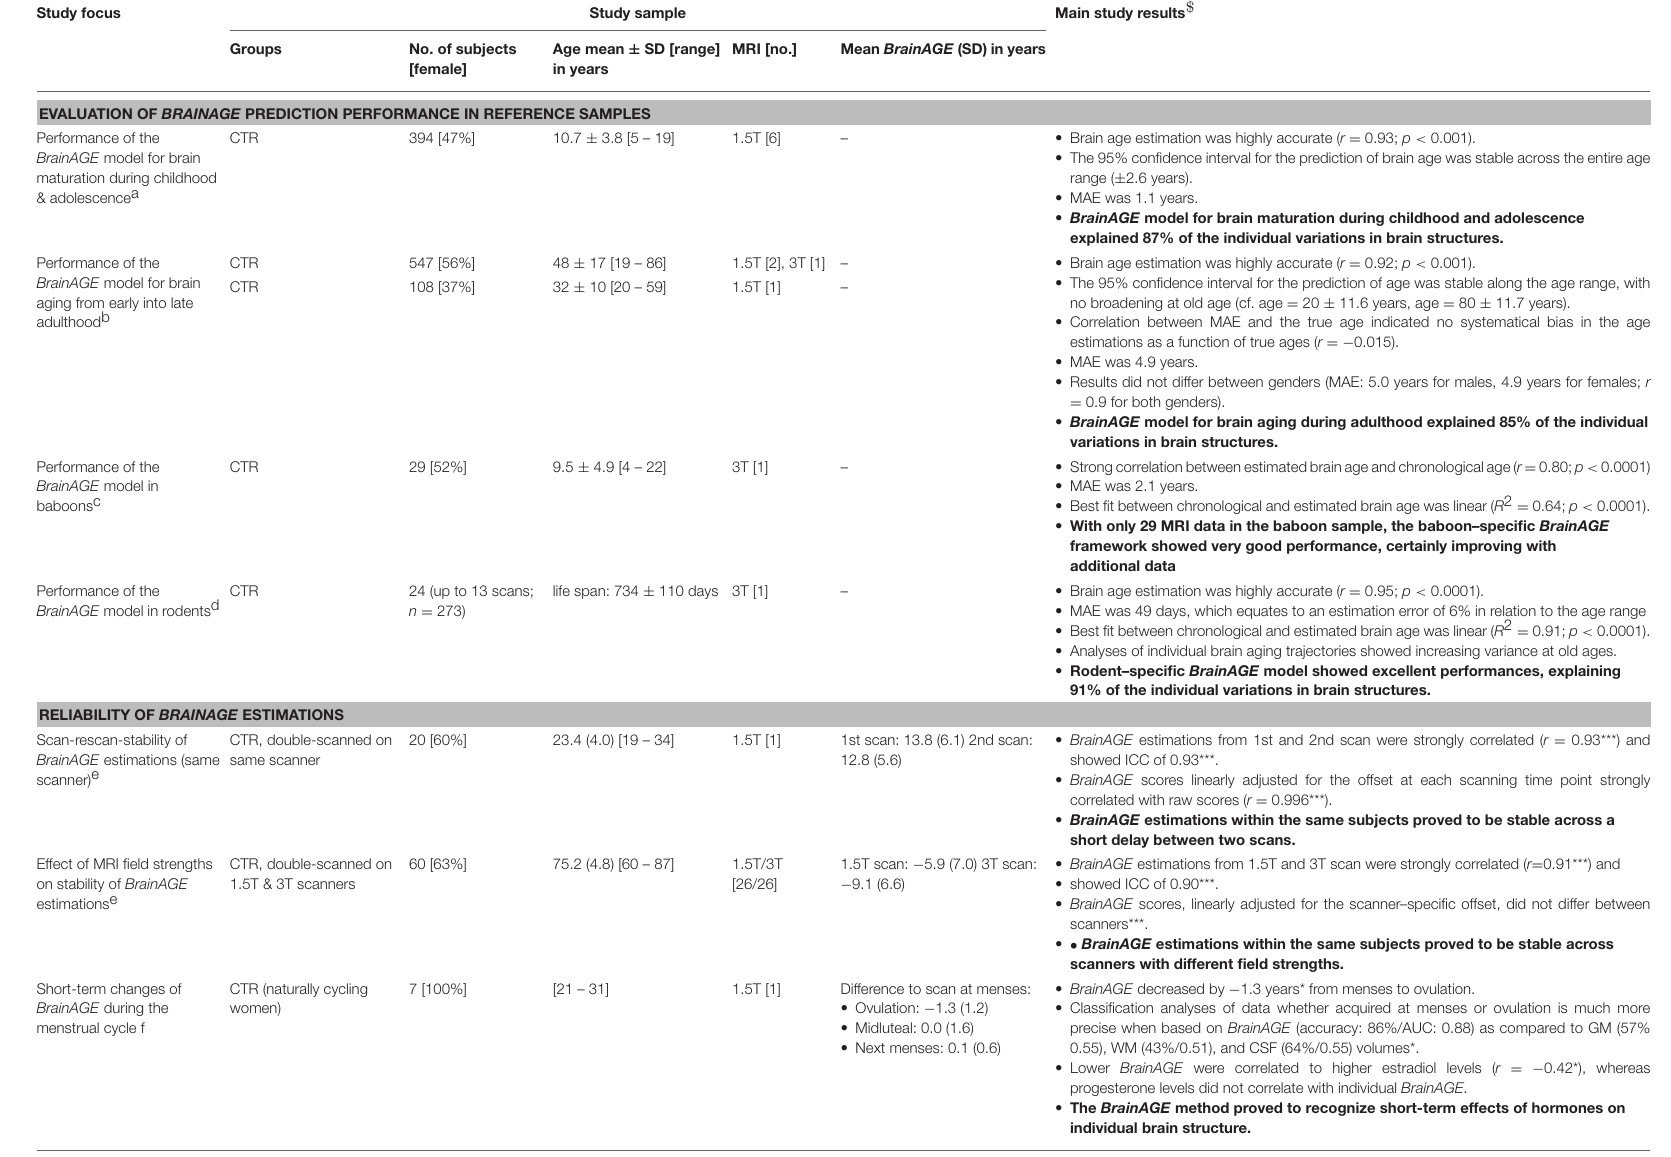
TABLE 1 | Studies utilizing the BrainAGE model for analyzing individual brain